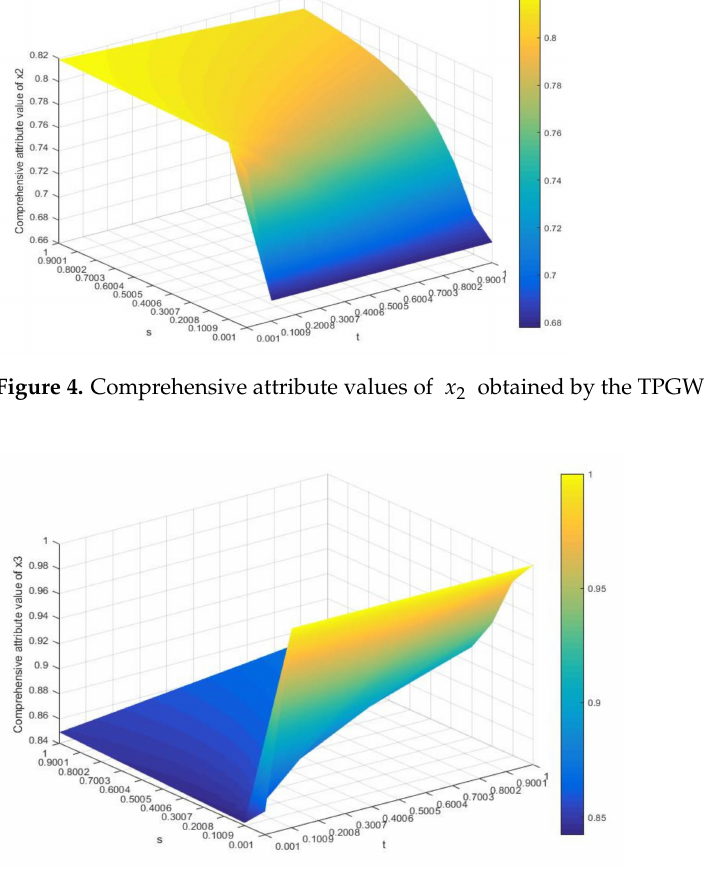
Figure 5. Comprehensive attribute values of x 3 obtained by the TPGWHM ( t , s ∈ [ 0.001,1 ] ).